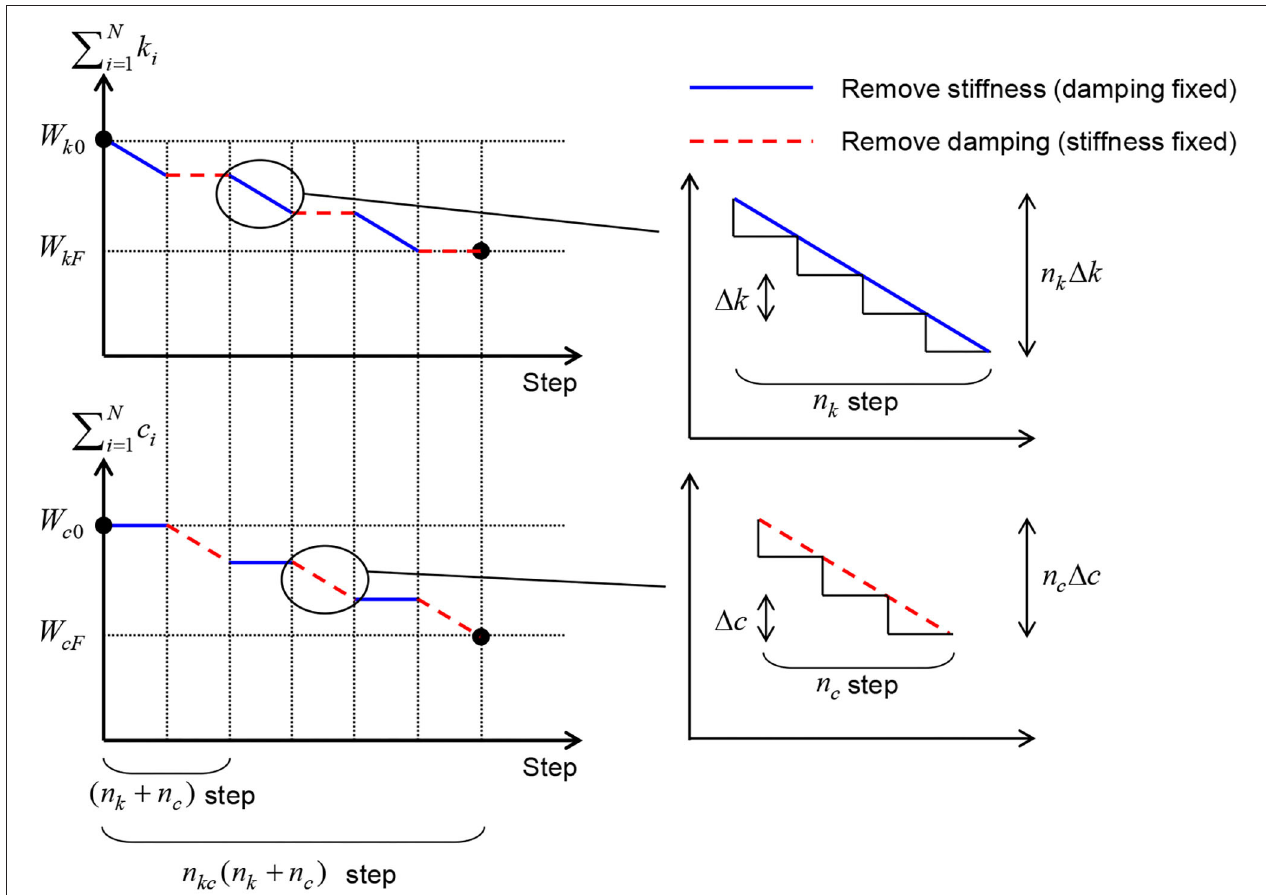
FIGURE 3 | Change of sum of story stiffnesses and sum of added damping coefficients throughout process of proposed solution algorithm.